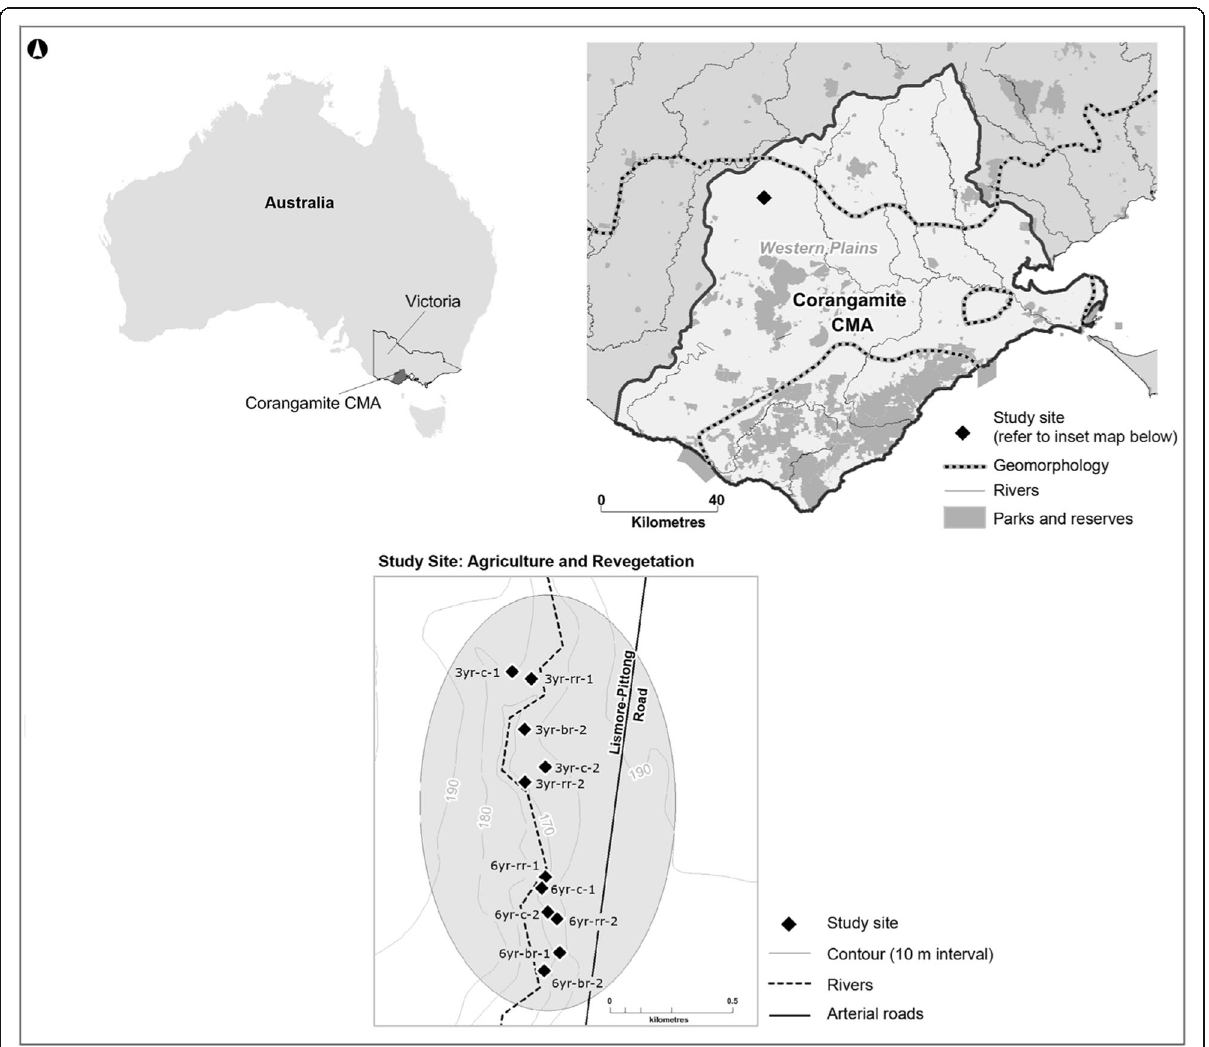
Fig. 1 At the top left hand corner is the study site, the Corangamite Catchment, in Victoria, Australia. At the top right hand corner is the detail of catchment authority area (CMA) and bottom picture showing the sampling locations in the farm. The land-use practice treatments at the 6-year- old reforested (RR) transect-1 is abbreviated as 6 yr-rr-1, the corresponding cropland (CP) as 6 yr-c-1, the bare riparian (BR) as 6 yr-br-1. Along the second transect the 6-year-old RR as 6 yr-rr-2, 3 yr-c-2 and 6 yr-br-2, respectively. Similarly, the 3-year-old RR as 3 yr-rr-1, 3 yr-c-1, 3 yr-br-1